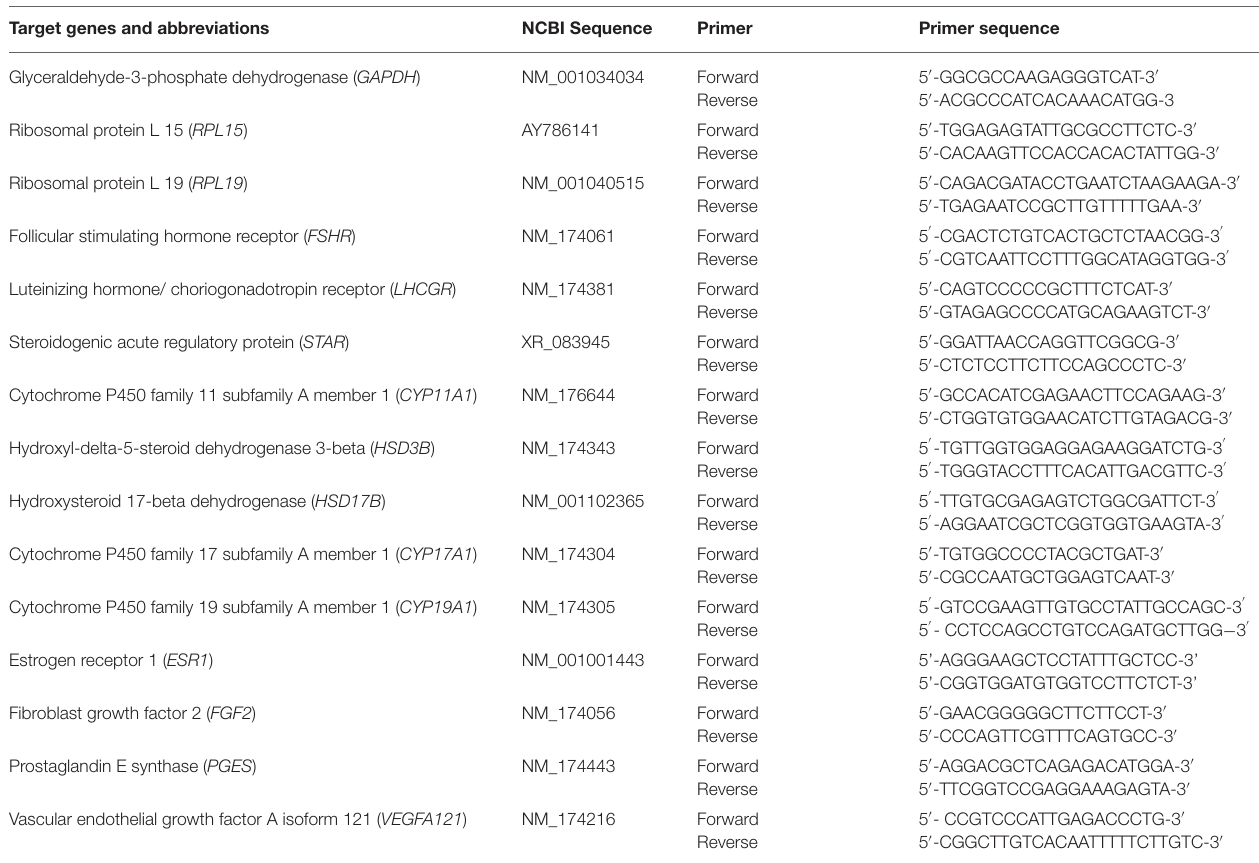
TABLE 1 | List of genes and primers used for quantitative real-time